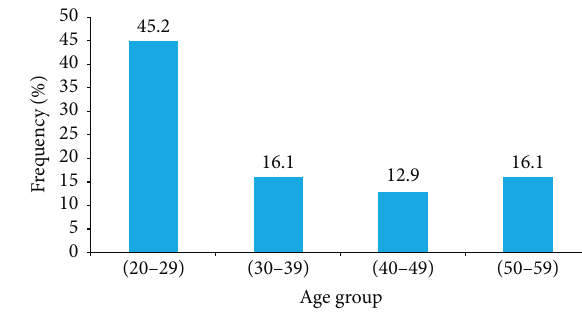
Figure 1: Distribution of patients by the age group.